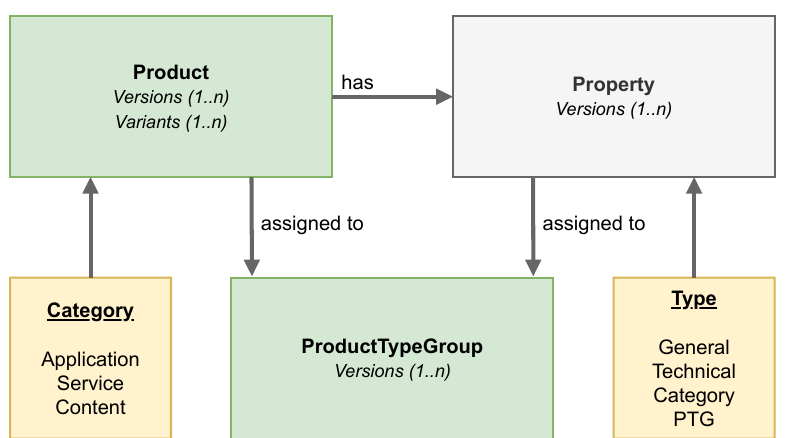
Figure 2. Relations between products, product-type groups, and properties in the data